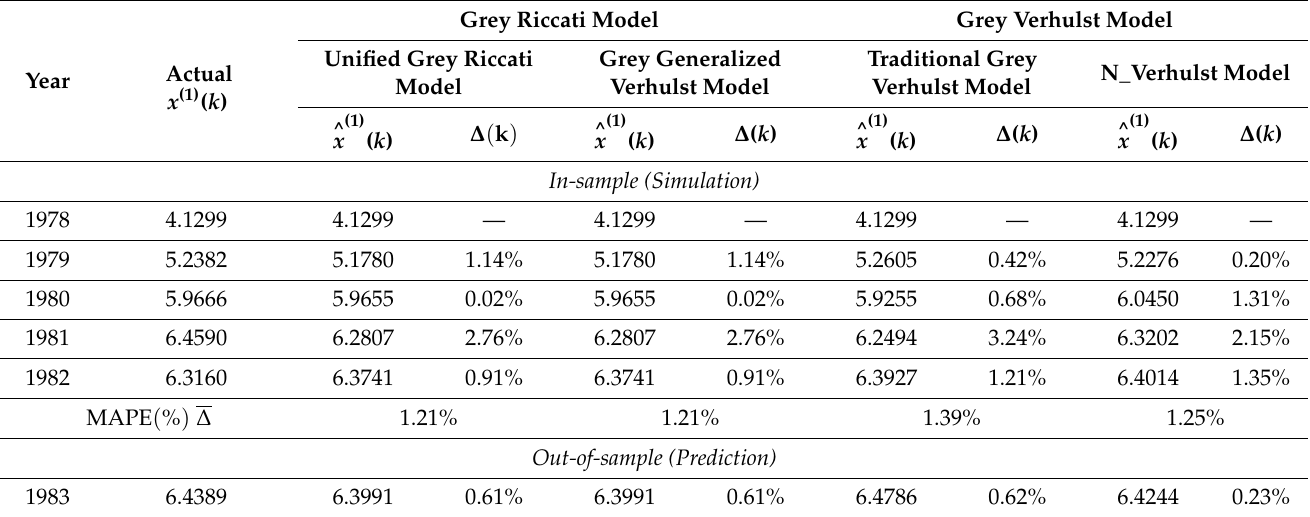
Table 2. Actual and simulative numbers of large and medium-sized agricultural tractors used in Henan Province (in ten